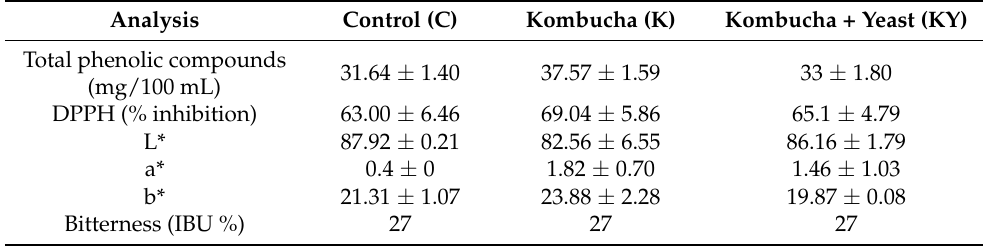
Table 4. Total phenolic compounds, DPPH analysis, color and bitterness of the produced beers. Analysis Control (C) Kombucha